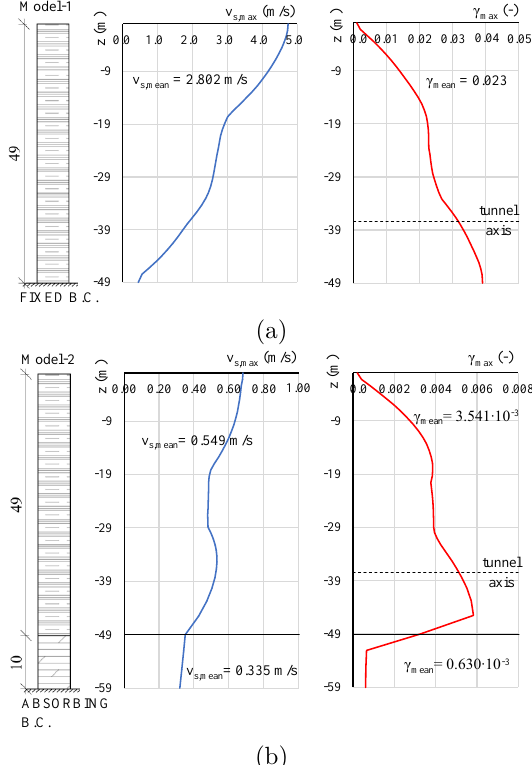
Figure 5. Distribution of maximum shear velocity and shear strain: a) fixed boundary, b) absorbing boundary.